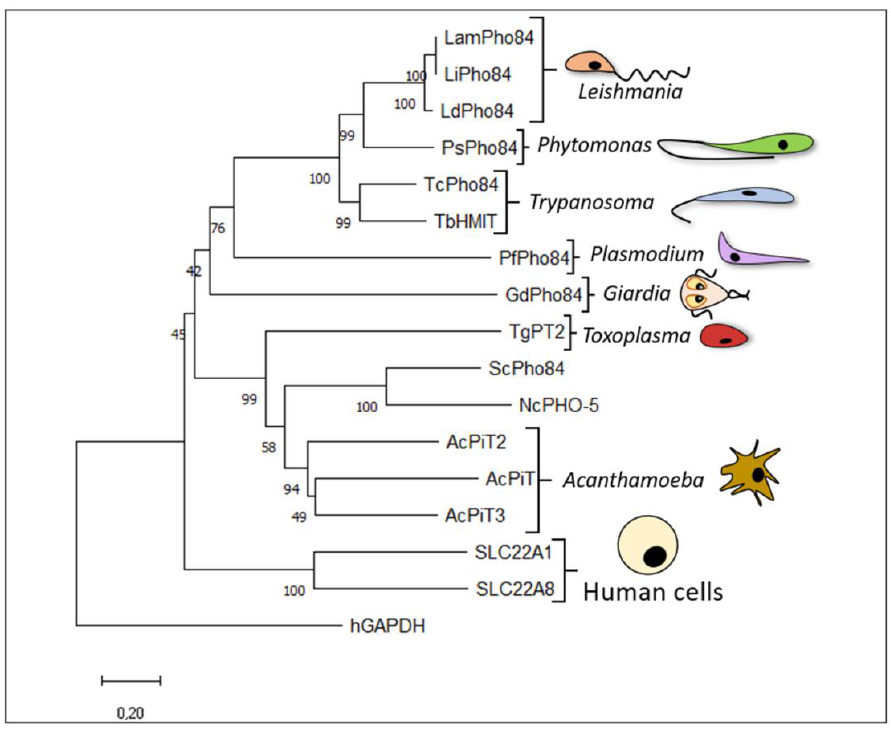
+ :Pi transporters from the PHS